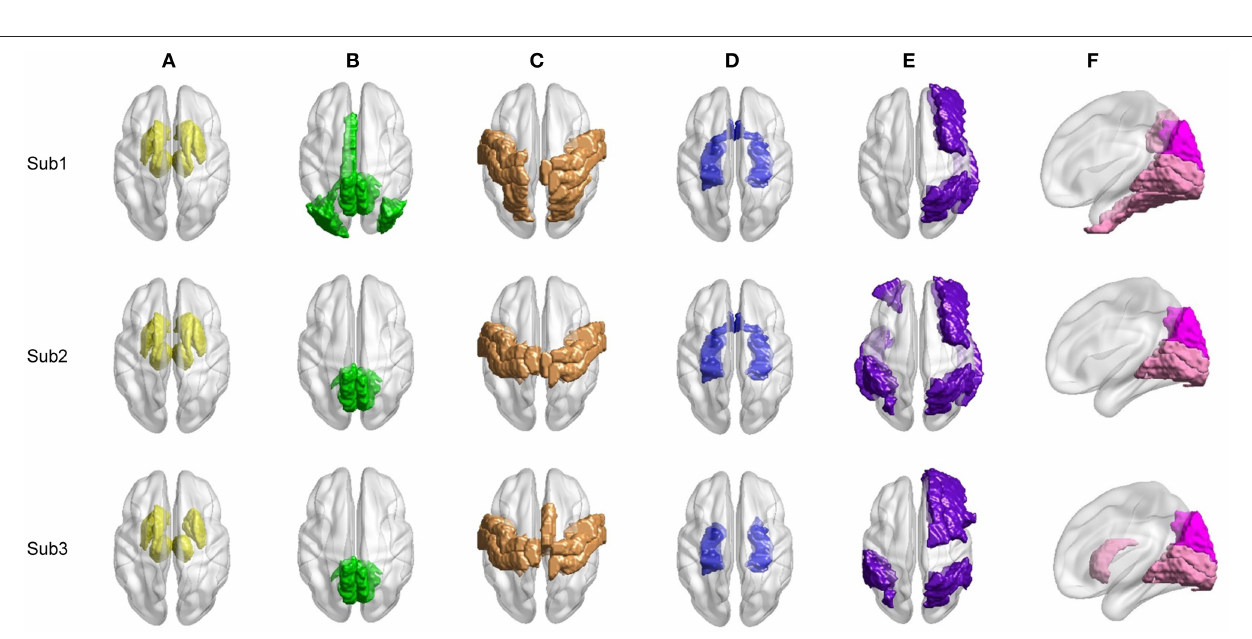
FIGURE 6 | Silhouette values of ASR and the Pearson correlation with varying numbers of clusters. Each colored line represents the results of one subject. The solid lines illustrate the Silhouette performance of the AP clustering results based on ASR while the dashed lines based on the Pearson correlation. (A) Mean Silhouette values. (B) Examples of Silhouette values on five randomly selected subjects.